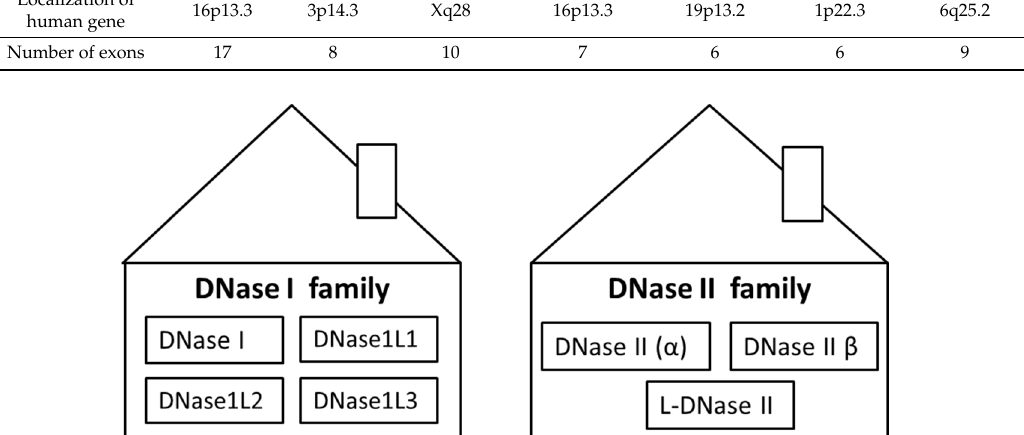
Figure 1. Classification of deoxyribonucleases (DNases) to two families. DNase I family includes four types of DNases: DNase I, DNase1L1, DNase1L2 and DNase1L3. DNase II family includes three types of DNases: DNase II ( α ), DNase II β and L-DNase II.